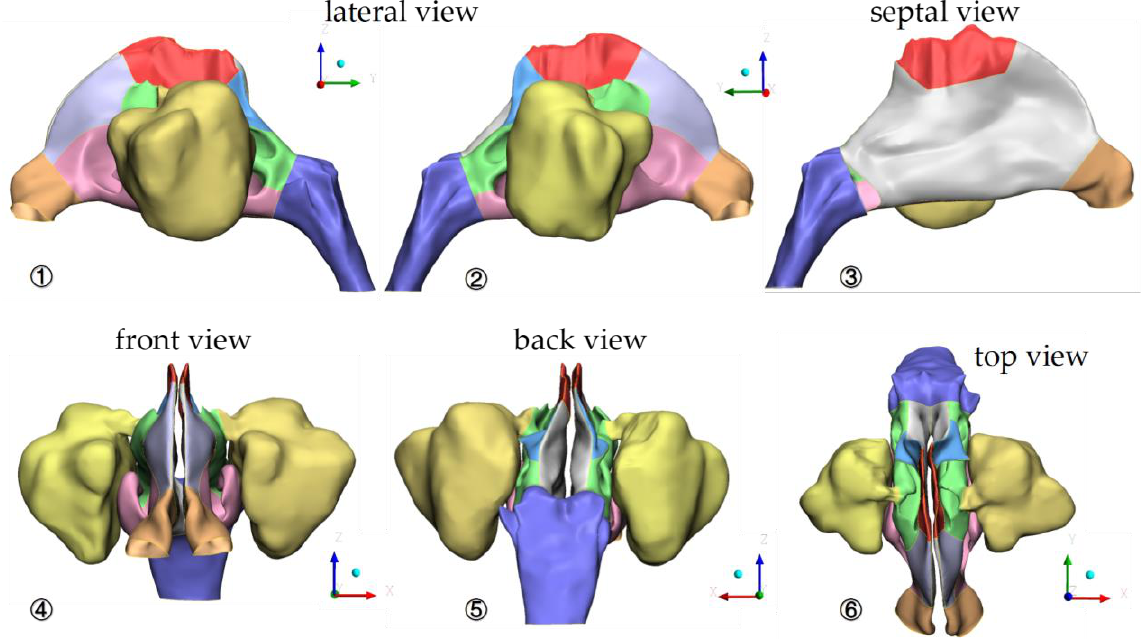
Figure 1. The 3D model and regional division of the nasal cavity: ① the lateral wall of the nasal cavity in the left view; ② the lateral wall of the nasal cavity in the right view; ③ the septum in the right view; ④ the front view; ⑤ the back view; ⑥ the top view (orange: nasal vestibule; yellow: maxillary sinus; lilac: lateral wall of nasal atrium; red: olfactory area; blue: superior turbinate area; green: middle turbinate region; pink: inferior turbinate area; dark purple: nasopharynx; gray: nasal septum).